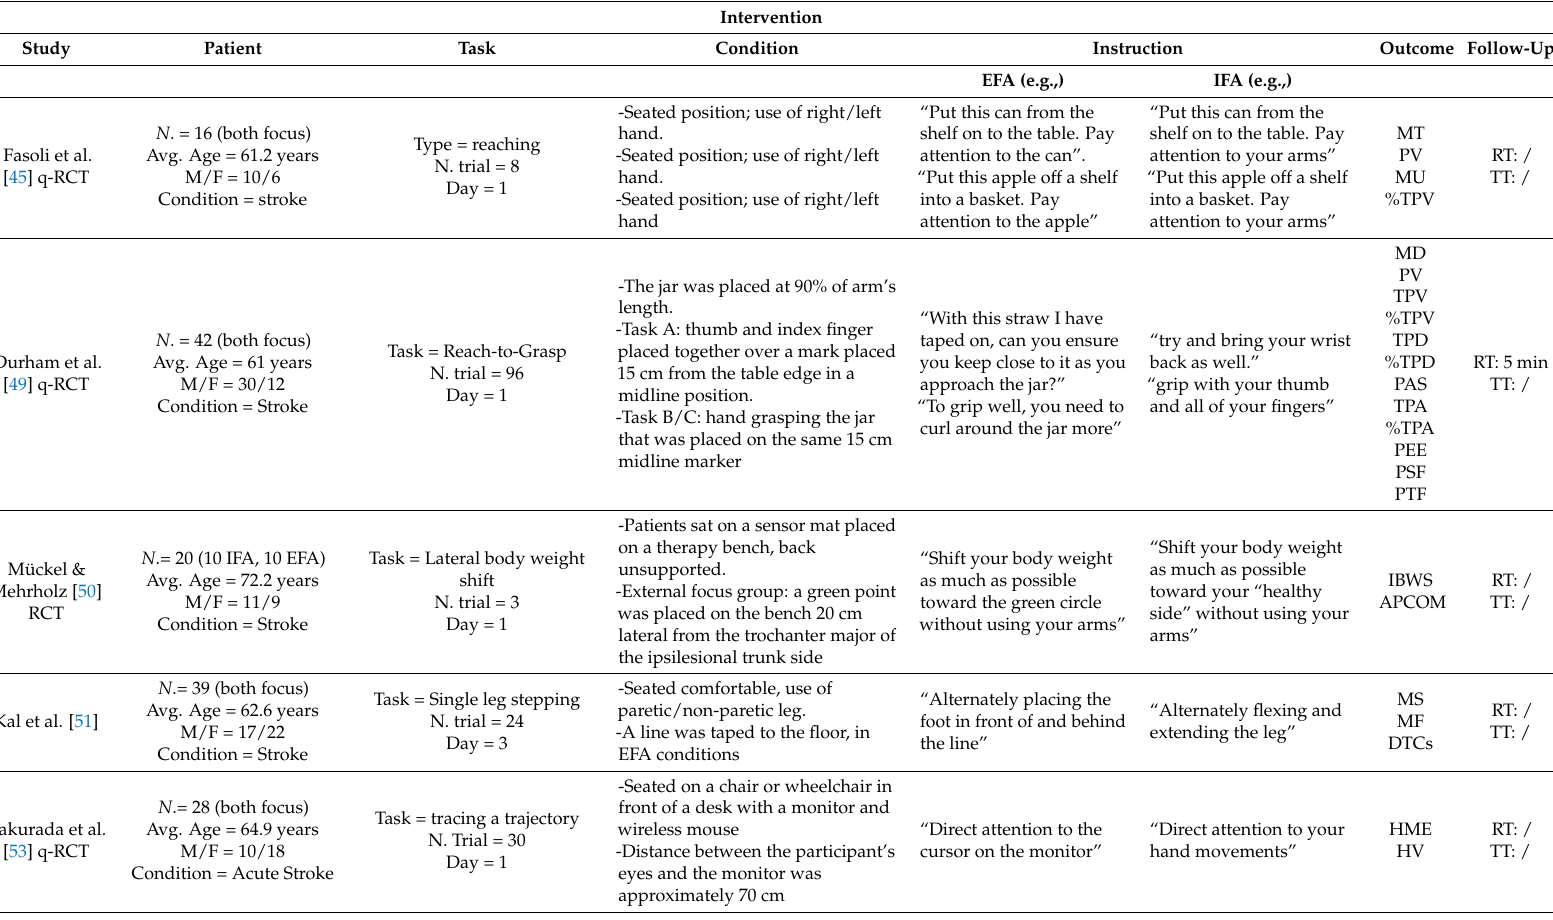
Table A2. Characteristics of the studies regarding patients with